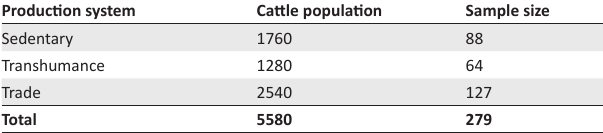
TABLE 1: Population size and number of animals sampled from each cattle production system in Yewa Division,